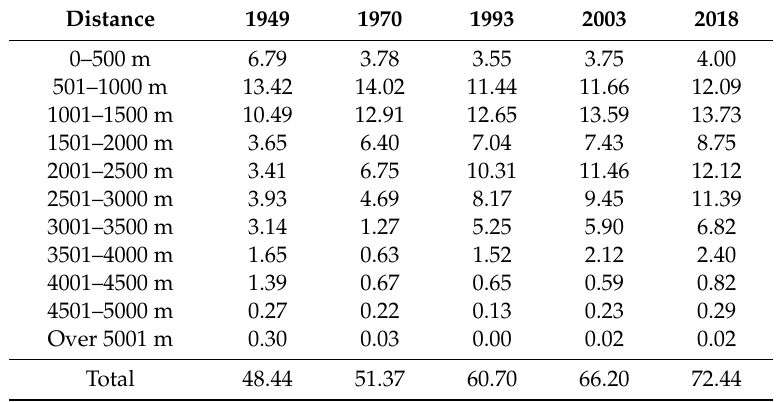
Table 6. The areas of individual housing related to railroad station accessibility (in hectares).